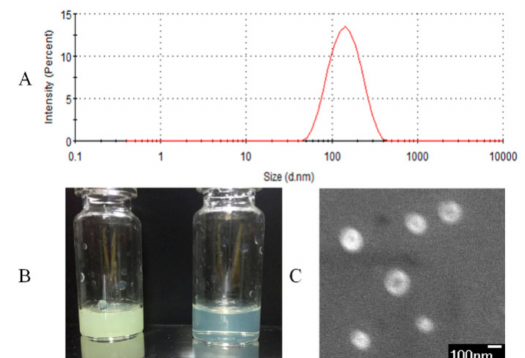
Figure 2. Characterization of nifedipine liposomes. ( A ) The particle size of nifedipine proliposomes after redissolving. ( B ) The appearance of nifedipine liposomes at 1.4 mg / mL (yellow) and at 140 µ g / mL (canary). ( C ) SEM of nifedipine proliposomes ( × 33,000) at 3.0 kV.